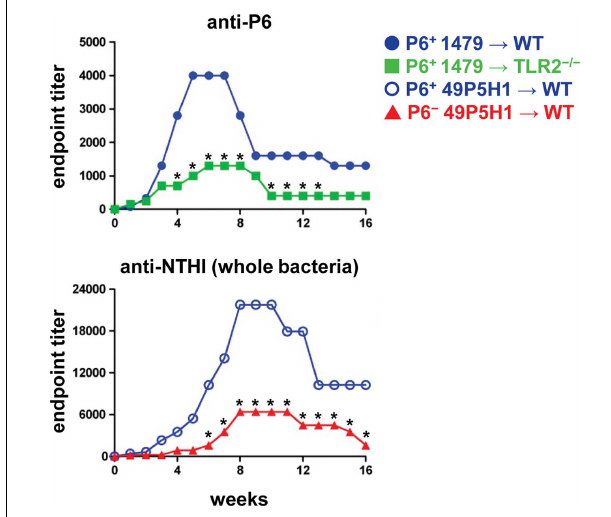
FIGURE 4 |Titers of anti-P6 and anti-NTHI Ig in serum. Indirect ELISA was used to measure Ig levels in mice exposed to NTHI. Purified P6 was • used to measure anti-P6 Ig in mice exposed to P6 + 1479 ( , (cid:2) ) and intact NTHI 49P5H1 was used to measure anti-NTHI levels in mice exposed to (cid:2) P6 + 49P5H1 ( (cid:3) ), or P6 − 49P5H1 ( ). * p < 0.01, two-way ANOVA with Bonferroni post-test comparison between groups. Average ± SEM.